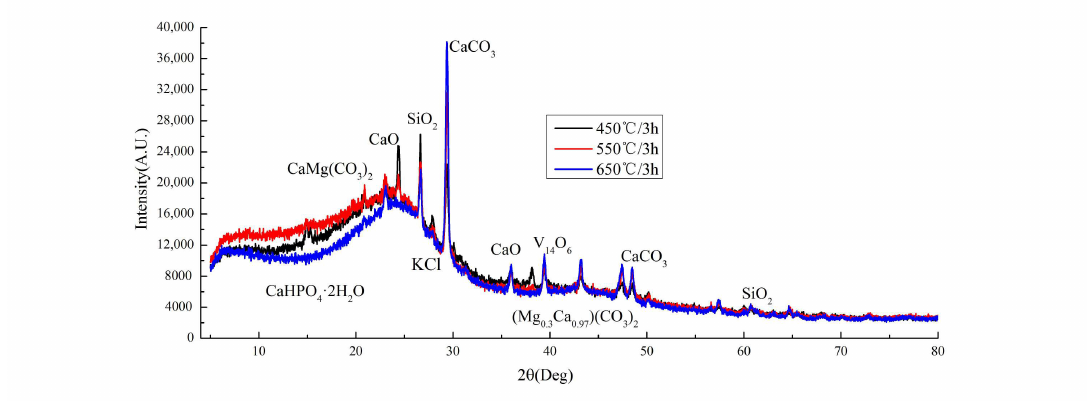
Figure 5. XRD patterns of CB biochar under di ff erent pyrolysis processes (taking 3 h as an